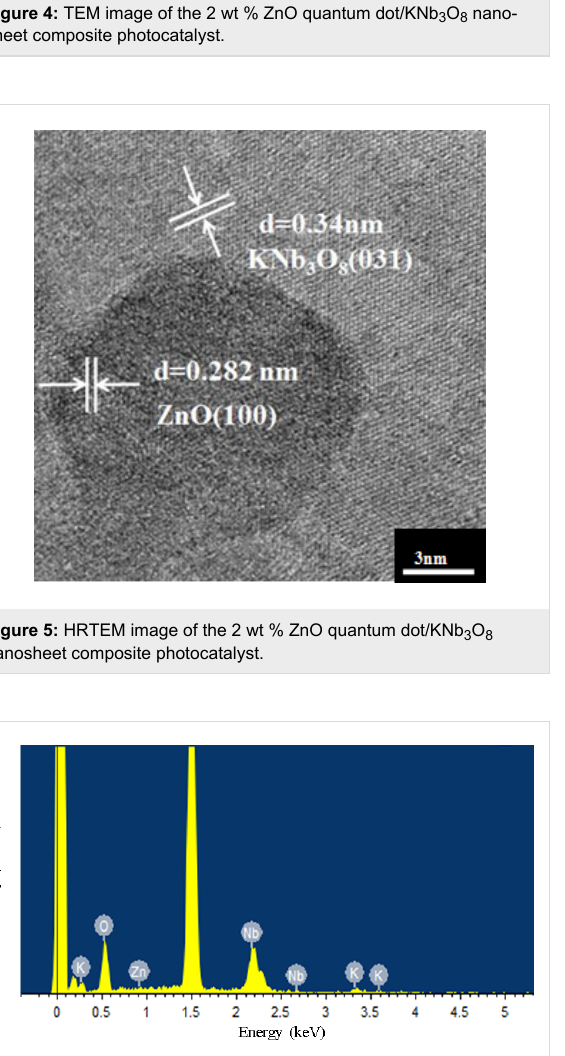
Figure 6: Energy dispersive X-ray spectroscopy pattern of the 2 wt % ZnO quantum dot/KNb 3 O 8 nanosheet composite